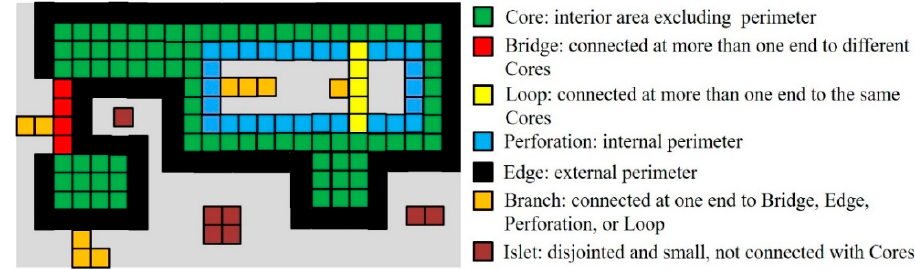
Figure 4. Seven classes of morphological spatial